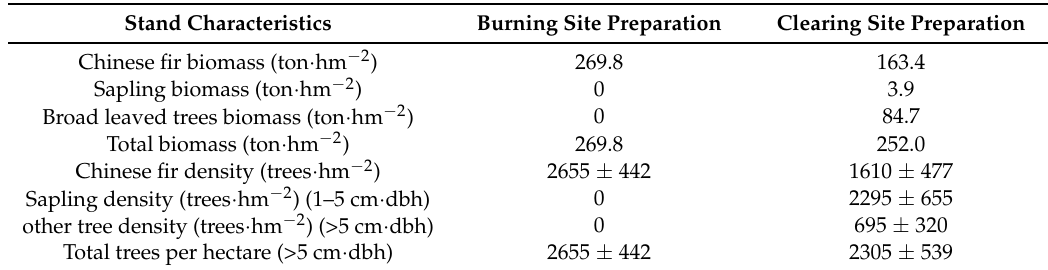
Table 2. Trees · ha − 1 and total biomass for Chinese fir in the controlled burning and brush clearing preparation